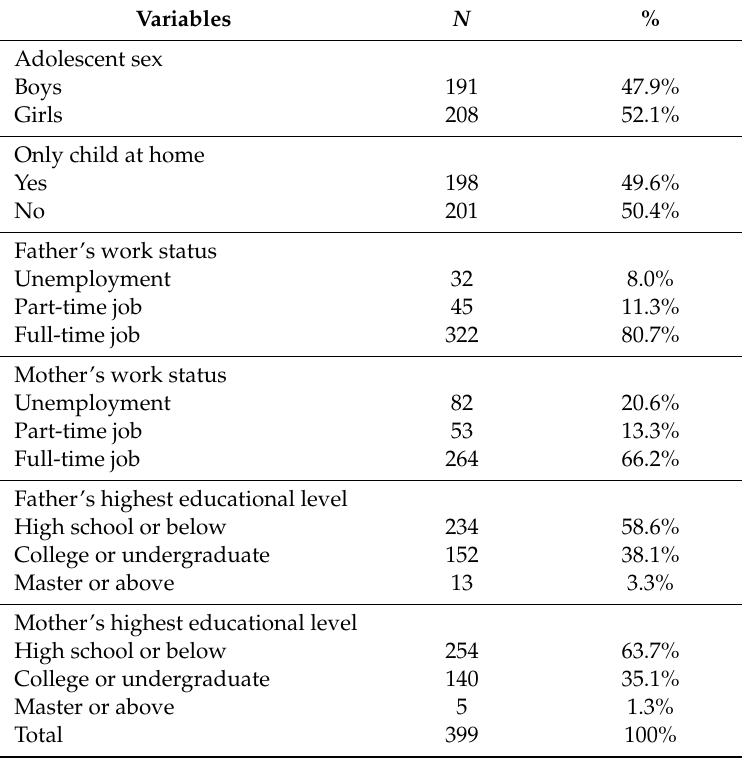
Table 1. Summary of the demographic variables at